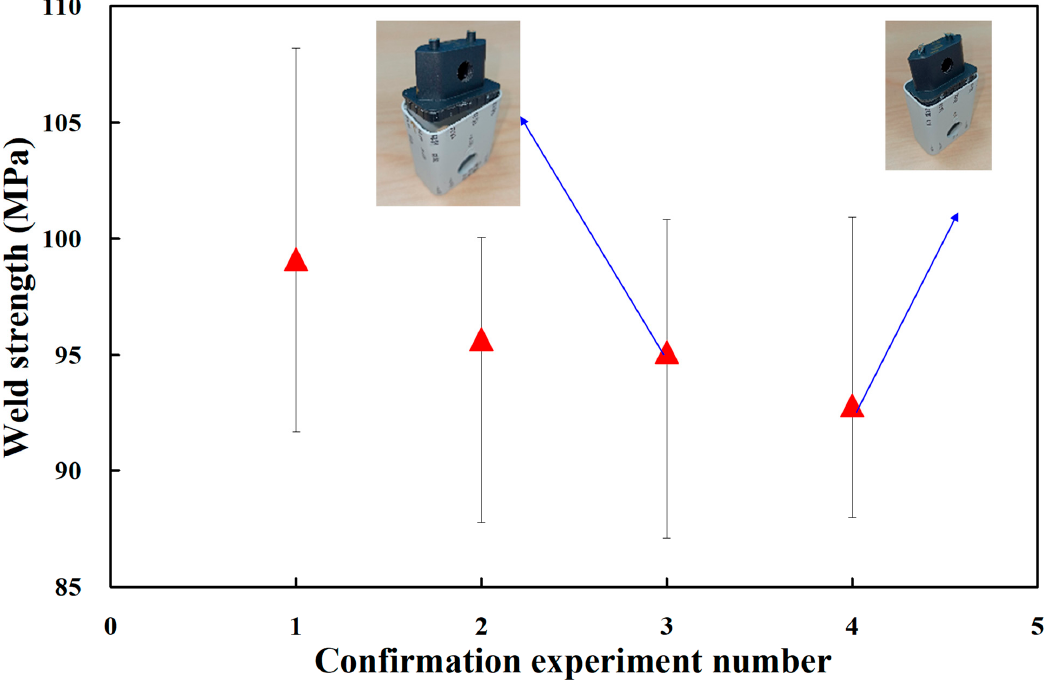
Figure 13. Results of confirmation experiments. Table 5. Results of verifying optimum process parameters.